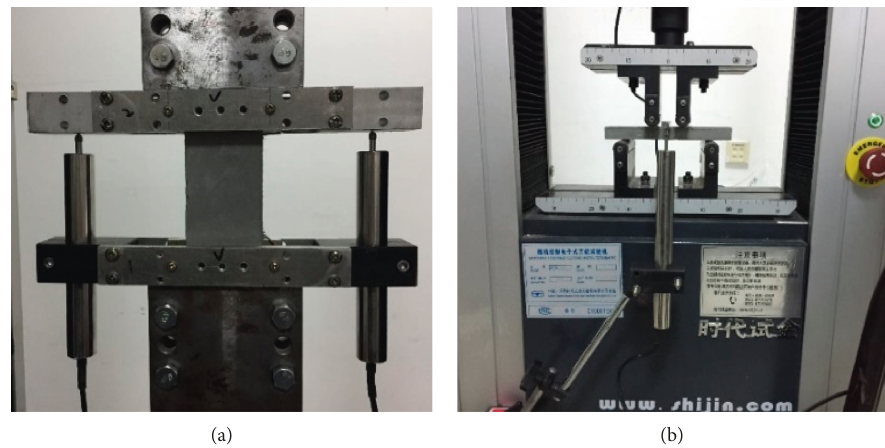
Figure 2: Testing setups for mechanical behavior: (a) uniaxial tensile test and (b) four-point bending test.